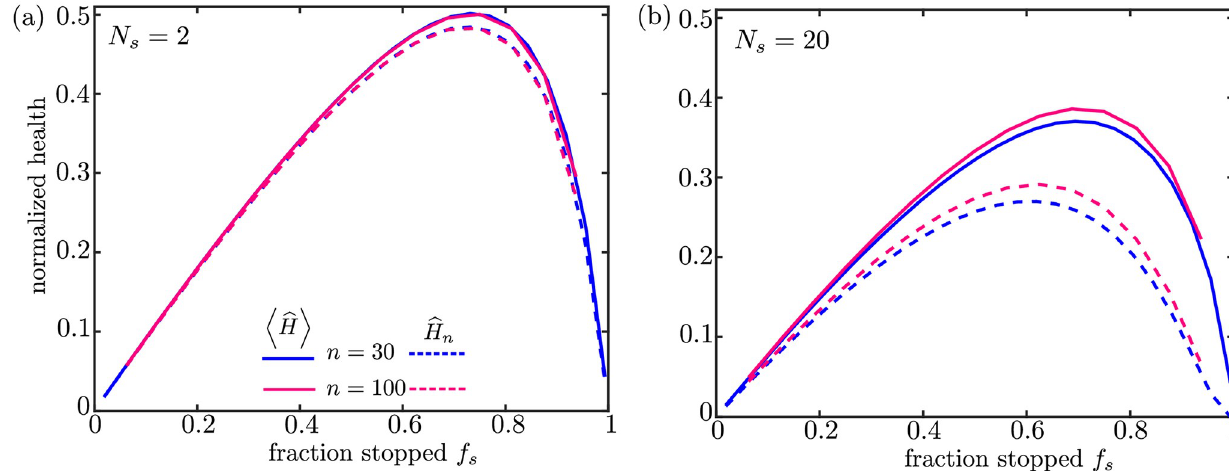
Fig 4. Mitochondrial health as a function of key dimensionless parameters. Solid curves show normalized average health over all demand sites; dashed curves show normalized health at the most distal site. The number of demand sites is set to n = 30 (blue) or n = 100 (magenta). For each fraction of stationary mitochondria the fusion probability is adjusted to give a fixed number of stopping events for an individual protein traversing the domain: (a) N s = 2 and (b) N s = 20. All values shown are for the SS model, with M = 1600 and ^ k ¼ 0 : 06 . Results for different values of M are provided in S2 Fig. d